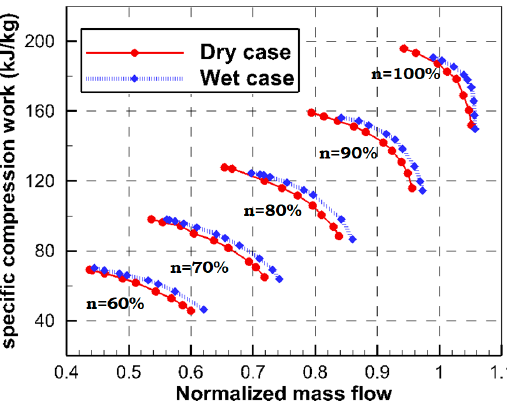
Figure 9. Contrast diagram of special work under dry and wet cases in a multistage compressor.